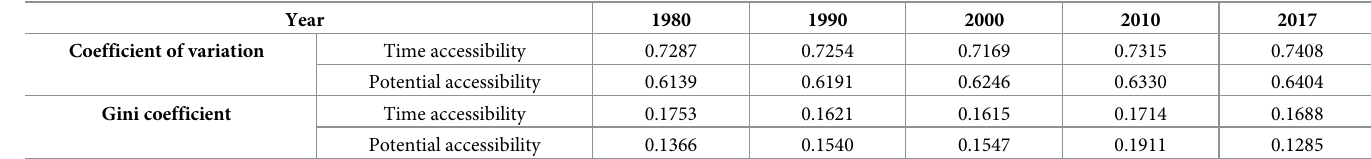
Table 2. Global coefficient of variation of transportation equity and the Gini coefficient of transport accessibility on the Tibetan